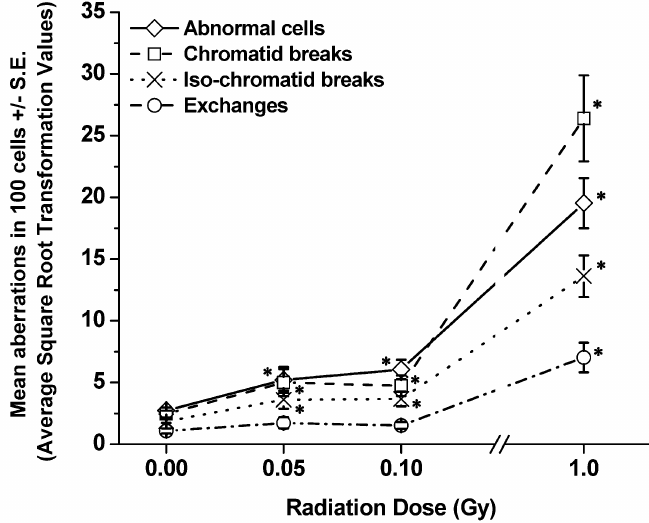
Figure 3. Frequencies of each type of aberration per 100 cells scored (±S.E.) detected in BM cells collected from SCID/J mice at 4 h post-irradiation. Significant differences in the frequencies of each type of CA in BM cells of exposed mice, as compared to the frequencies detected in non-irradiated sham controls are shown at “ 